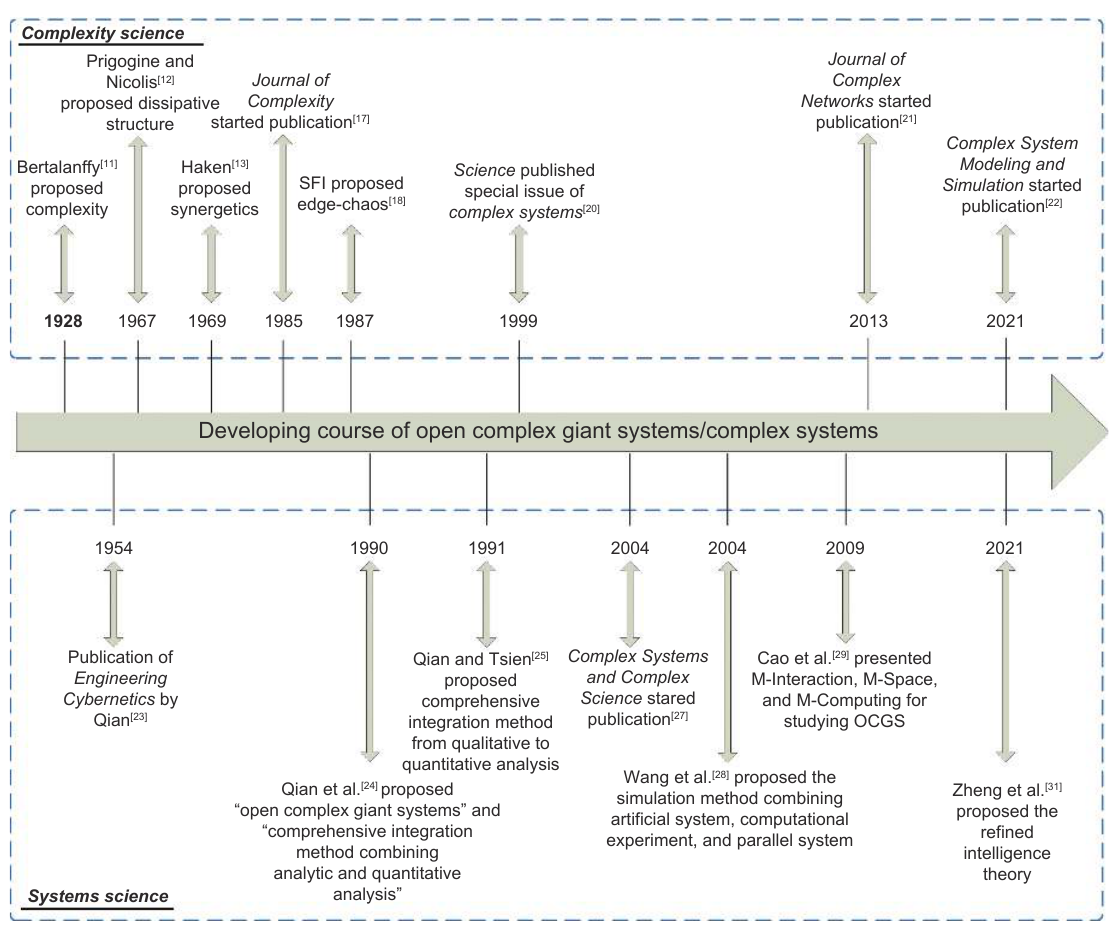
Fig. 1 Development course of complex